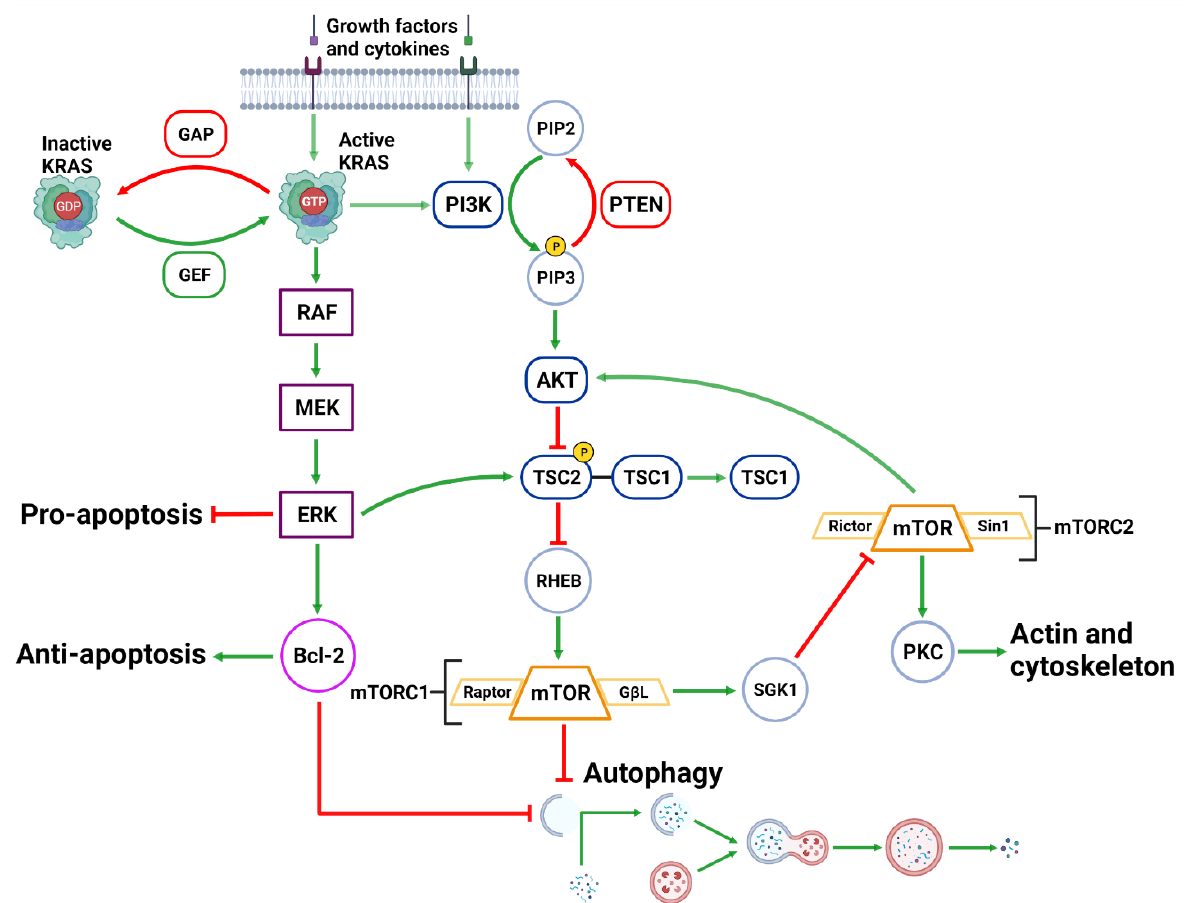
Figure 3. Upstream Autophagy Regulation. Extracellular growth factors and cytokines activate KRAS and PI3K. GAP and GEF regulate KRAS activity which begins the MAPK cascade of activating RAF, MEK and ERK. ERK can inhibit pro-apoptotic function and support anti-apoptotic function via Bcl-2. ERK can also inhibit mTORC1 which facilitates autophagic initiation. PI3K phosphorylates PIP3 which is regulated by PTEN dephosphorylation. PIP3 activates AKT causing the destabilization of TSC2-TSC1 complex. This supports mTORC1 activity and suppresses autophagic initiation. mTORC1 can also regulate AKT via a feedback loop and suppress cytoskeleton activity involving SGK1 and mTORC2. Created with BioRender.com (accessed on 28 March 2022).